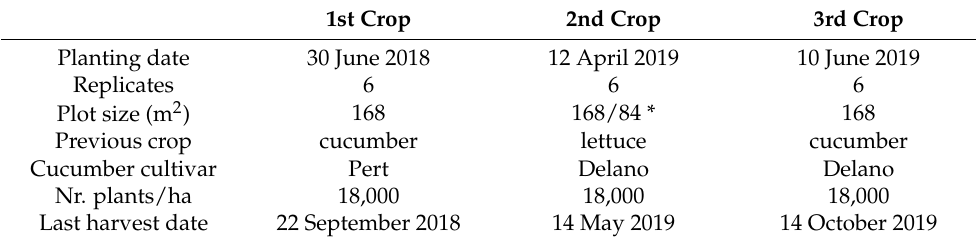
Table 2. Details of the three cucumber crops at the experimental scheme. 1st Crop 2nd Crop 3rd